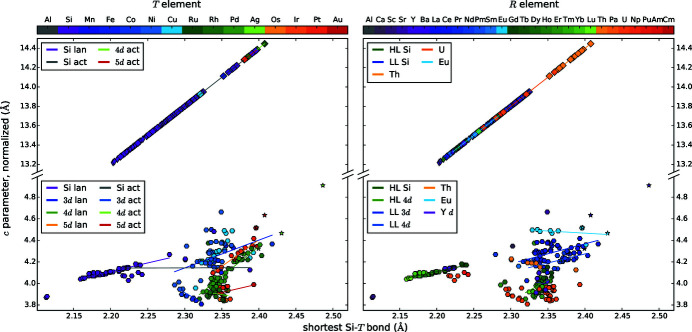
Correlations between the shortest Si—T distance d and the lattice parameter c. For ThSi2-like compounds c ∝ d by definition. The d value of AlB2-like compounds is separated in RSi2 compounds < 2.25 Å and R
2
TSi3 compounds > 2.28 Å.